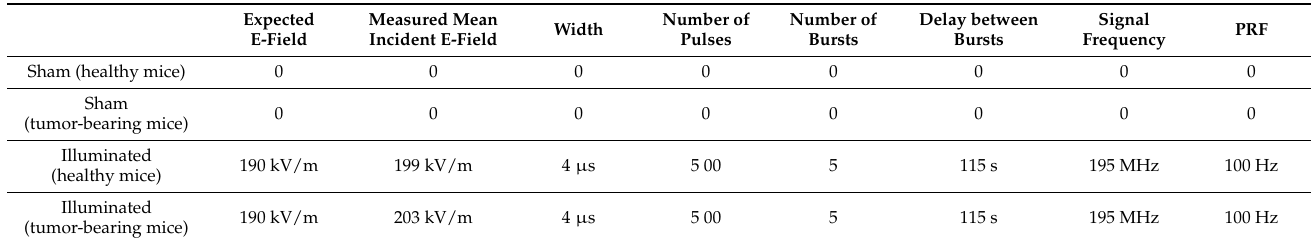
Table 3. Electromagnetic parameters applied in field experiments for wide-band (WB) illuminations of healthy and tumor-bearing mice (N = 10 mice/group).